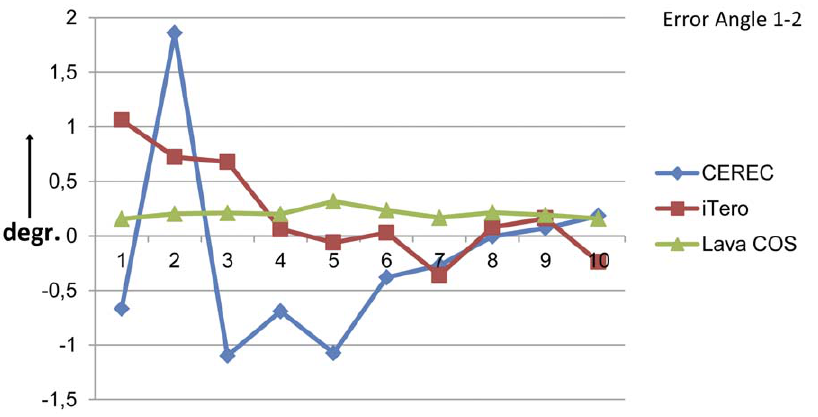
Figure 8. The angulation errors between the cylinders 1 and 2 in degrees for the three intra-oral scanners. The angulation errors were small and ranged from 2 0,0061 u (CEREC) to 1,8585 u (CEREC). The Lava COS showed the smallest mean angulation error and also the smallest variations. The Lava COS also showed only positive errors.